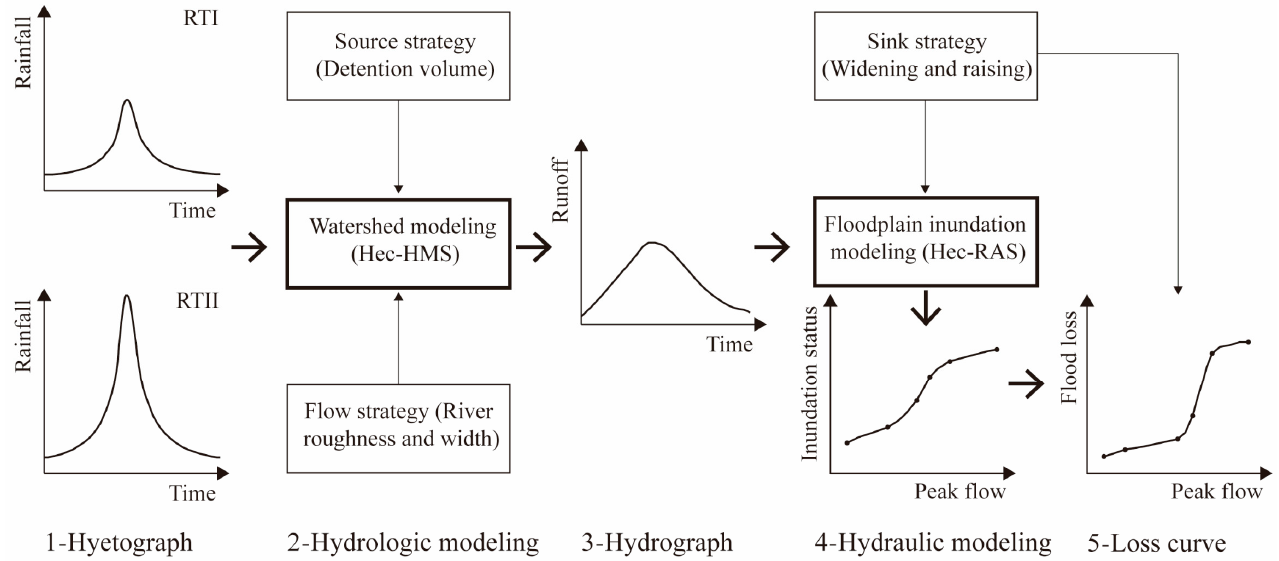
Figure 7. The integrated modeling process diagram of this study.